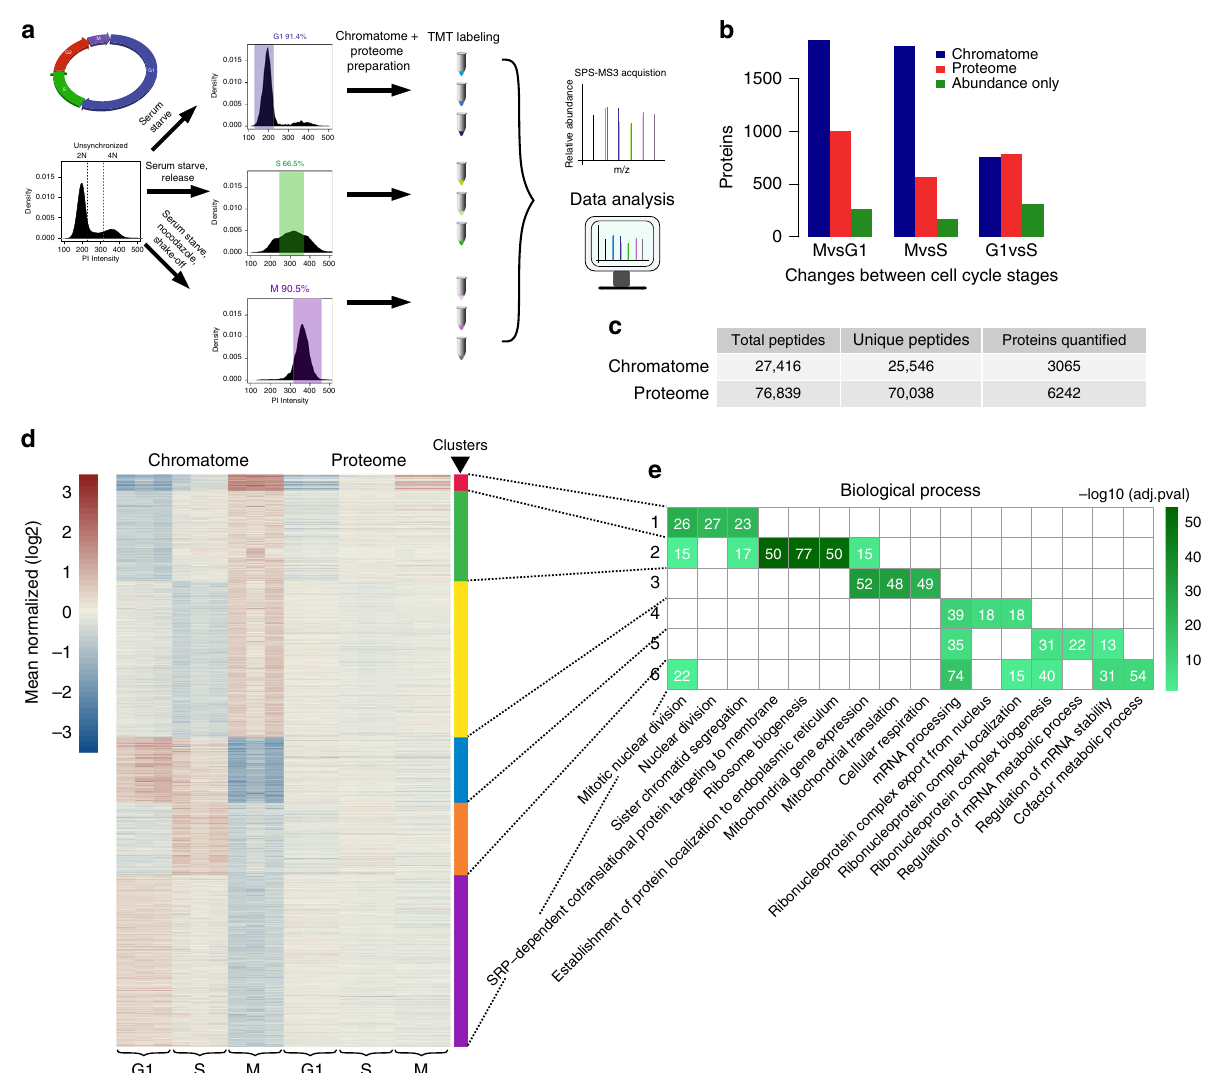
Fig. 2 Changes in chromatin association across the cell cycle. a Outline of experimental procedure. Density plots represent propidium iodide staining of cellular DNA content (2N = diploid copy number). Cutoffs for G1, S, and G2/M are represented by blue, green, and purple colored boxes, respectively. Synchronization procedures are noted above arrows. b Total number of signi fi cantly changing proteins between cell cycle contrasts ( p ≤ 0.001 and fold change ≥ 1.5, see Methods for signi fi cance determination), for proteome (red) and chromatome (blue) samples. Green bar represents those proteins where changes in chromatome correlate signi fi cantly with changes in proteome, and thus can be explained by protein abundance. c Number of proteins and peptides detected and quanti fi ed in proteome and chromatome. d Clustering of signi fi cantly changing chromatome proteins using af fi nity propagation clustering. Scale represents mean- normalized intensities after log2 transformation. Clusters are denoted by colored bars on the right with their respective numbers. e The top three biological process ontology terms associated with each cluster in d colored by − log10(adjusted p- value). Numbers in brackets represent number of proteins belonging to that category in the respective cluster as in